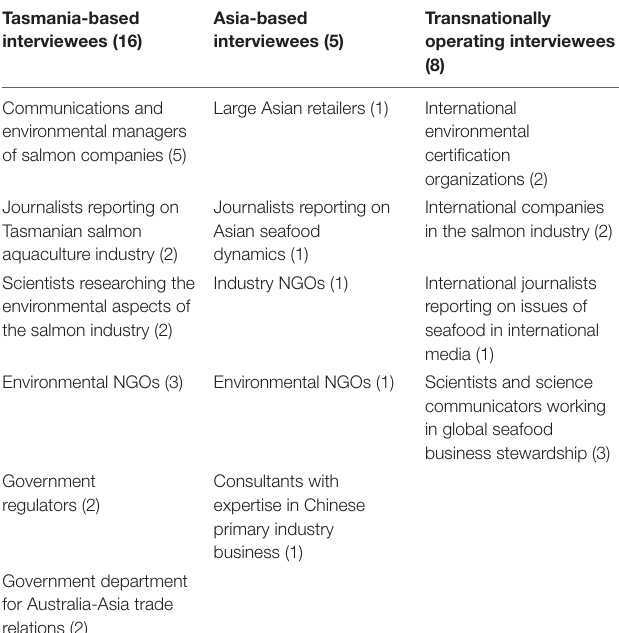
TABLE 1 | Areas of expertise that interviewees